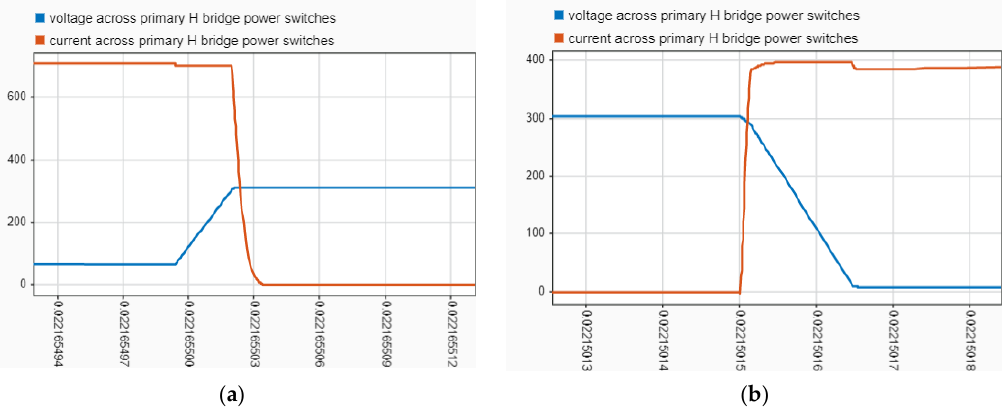
Figure 9. Output voltage and load power for 40 kW using perfect model and conduction loss model for DAB DC-DC converter: ( a ) DC bus output voltage; ( b ) load power.